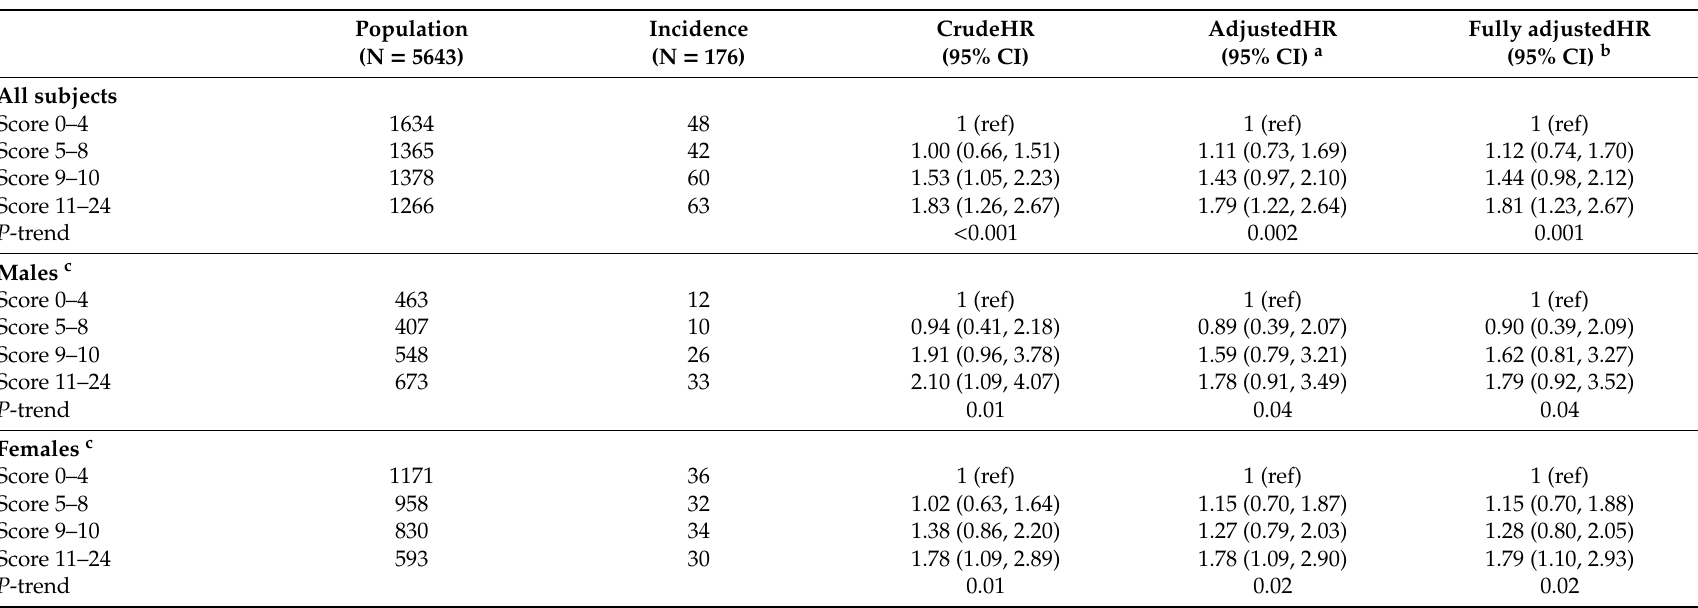
Table A6. Comorbidity scores and the risk of cancer incidence in subjects regardless of time to cancer diagnosis.